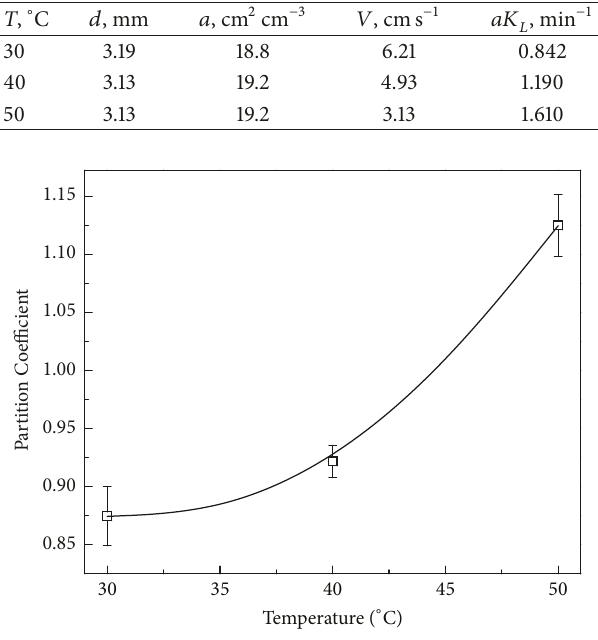
Figure 4: Plot of the partition coefficient as a function of the temperature of the